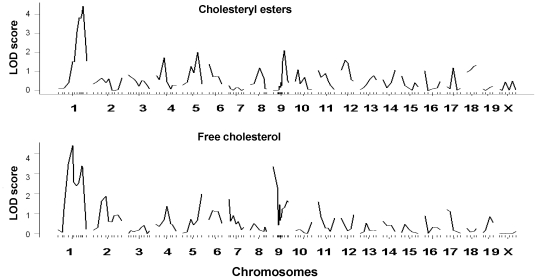
Genome-wide analyses for main effect loci affecting plasma esterified cholesterol and free cholesterol of female F2 mice between B6.apoE−/− and C3H.apoE−/− mice using the R/qtl program.Female F2 mice were fed the western diet for 12 weeks and typed for genetic markers spanning the genome and for the phenotypes. Chromosomes 1 through X are represented numerically on the X-axis. The relative width of the space allotted for each chromosome reflects the relative length of each chromosome. The Y-axis represents the LOD score.